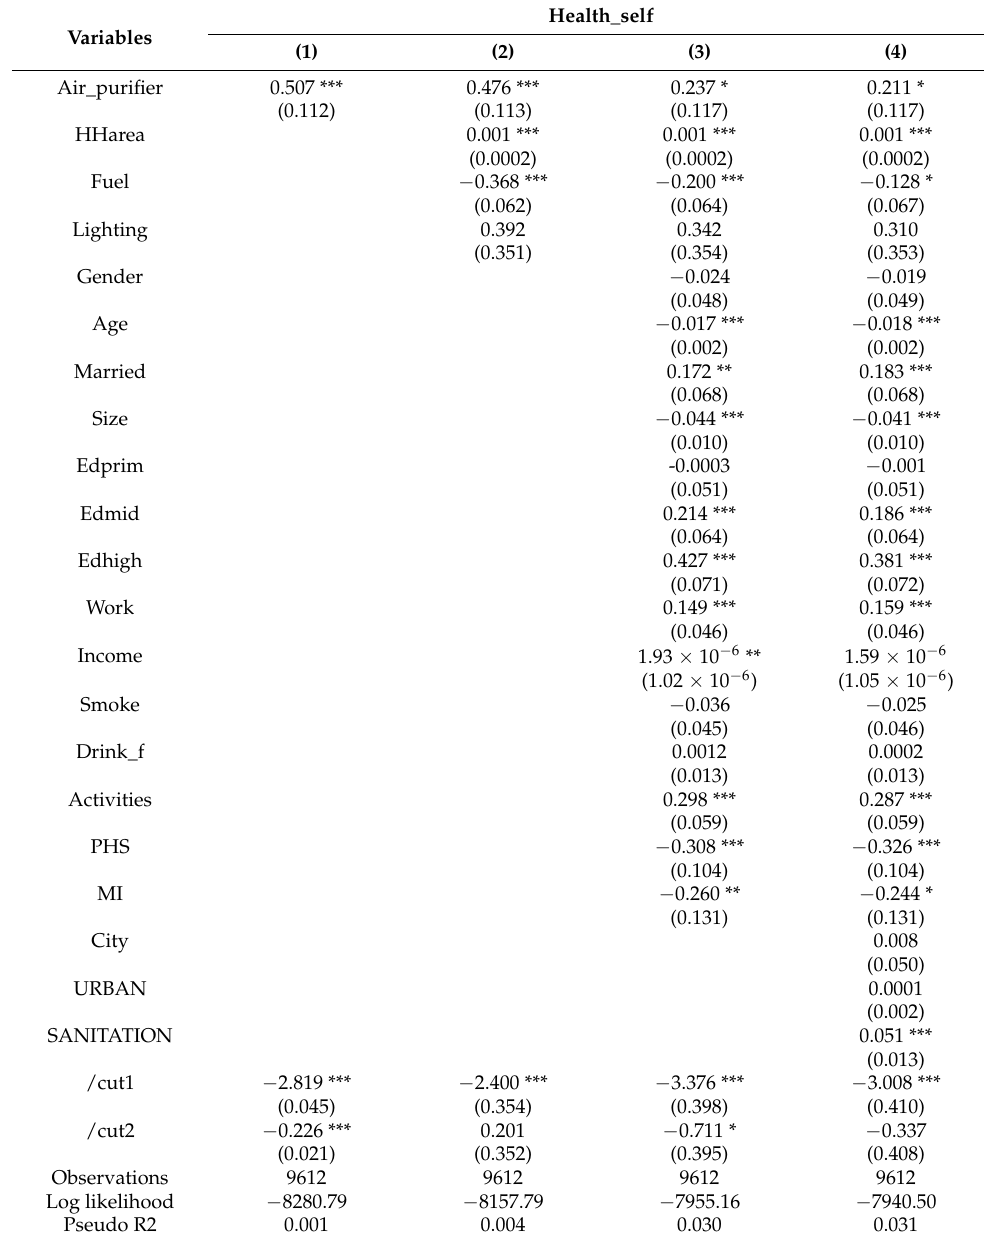
Table 2. Regression results of the effect of indoor air purification on residents’ self-rated health based on the ordinal logit